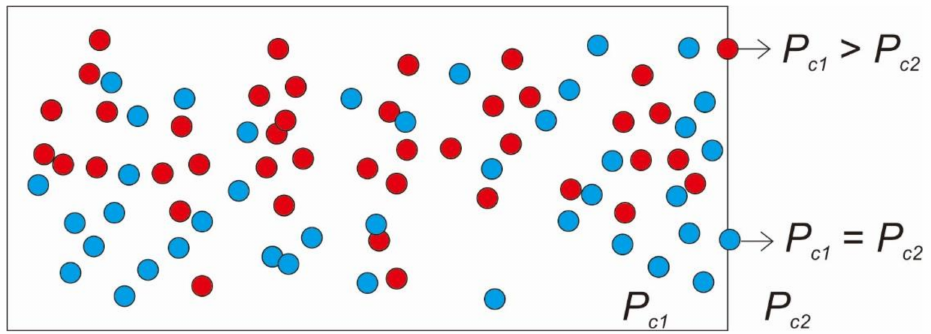
Figure 1. Physical schematic figure of the capillary end effect. In order to achieve capillary balance, the wetting phase (blue) will gather at the outlet end. This phenomenon continues until the saturation of the wetting phase reaches the saturation when the capillary force is zero. However, the non-wetting phase (red) will not accumulate at the outlet